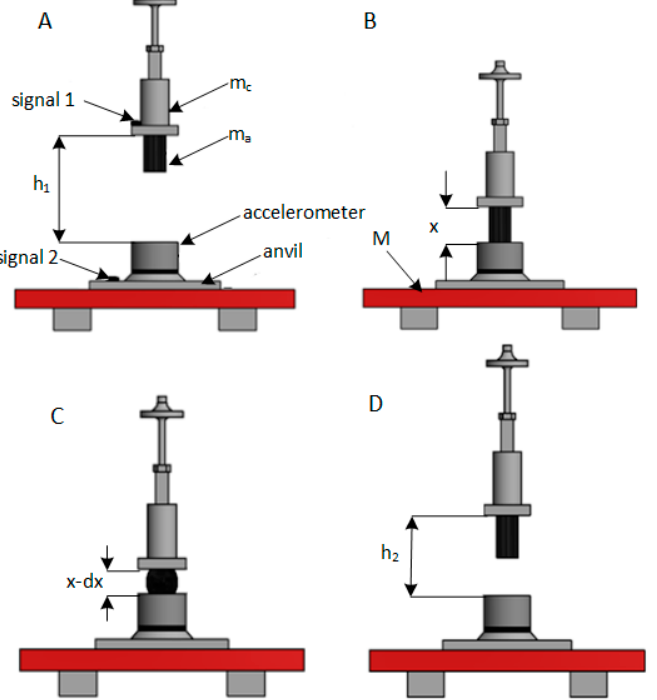
Figure 4. Diagrams of theoretical foundations for conducted research. ( A ) initial hammer drop position, ( B ) point of absorber contact with the anvil, ( C ) point of maximum absorber deflection, ( D ) point of maximum rebound height